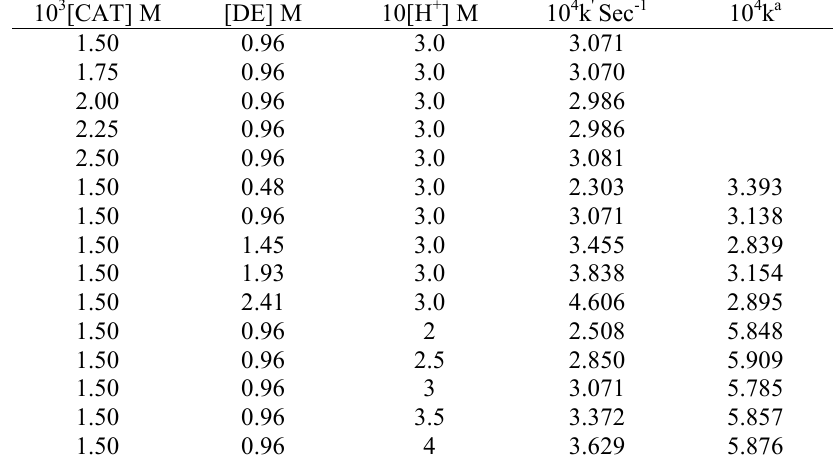
Table 1 . Effect of varying of chloramine-T, diethyl ether, and hydrogen ion concentration on the reaction rate.